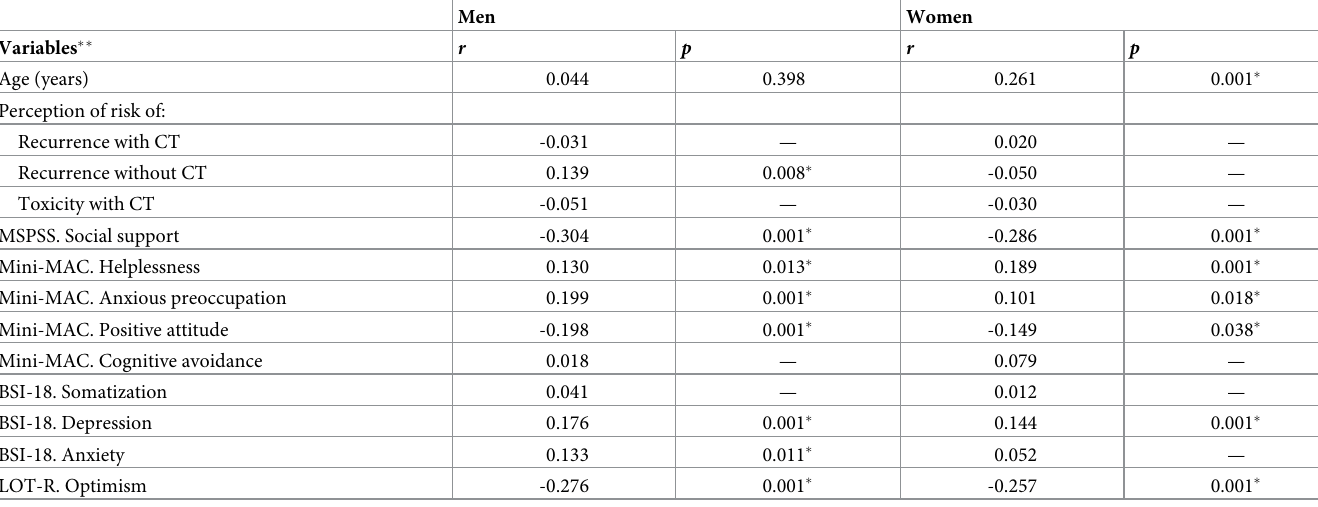
Table 4. Correlation between stoicism, perception of risk of recurrence and toxicity, psychological scales in men and women with cancer. Men